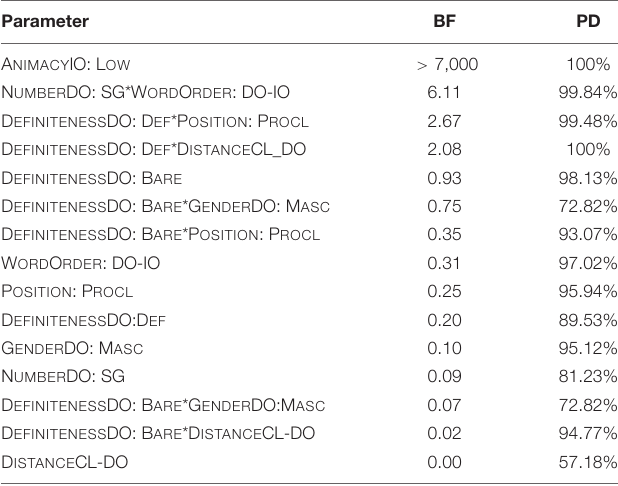
TABLE 3 | Bayes factors (BF) and probability of direction index (PD) for each predictor variable of the mixed-effect Bayesian model. Parameter BF